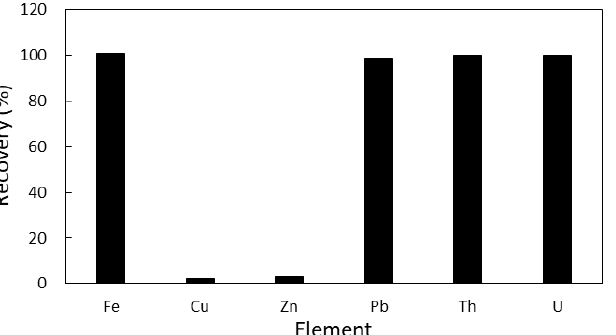
Figure 1. Recovery efficiencies of six elements for SS-1 using Fe(OH) 3 precipitation. AG1-X8 is a common anion exchange resin used in the analysis of geological samples.